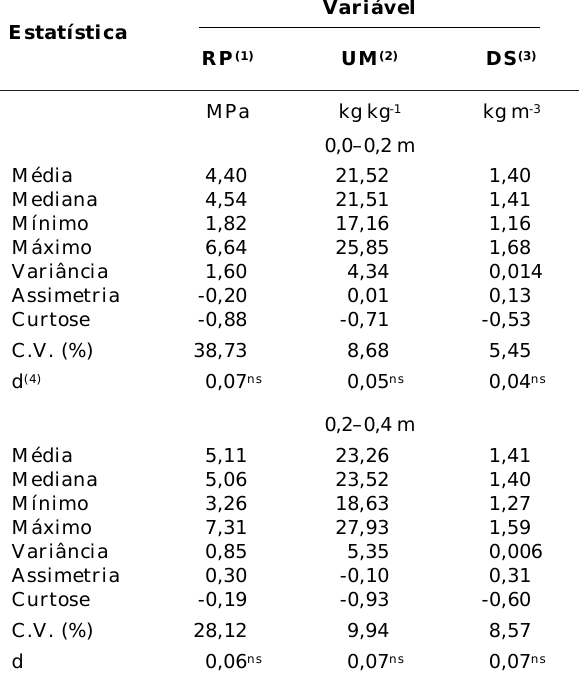
(1) RP = resistência à penetração. (2) UM = umidade do solo. (3) DS = densidade do solo. (4) d = ns não-significativo a 5 % pelo teste